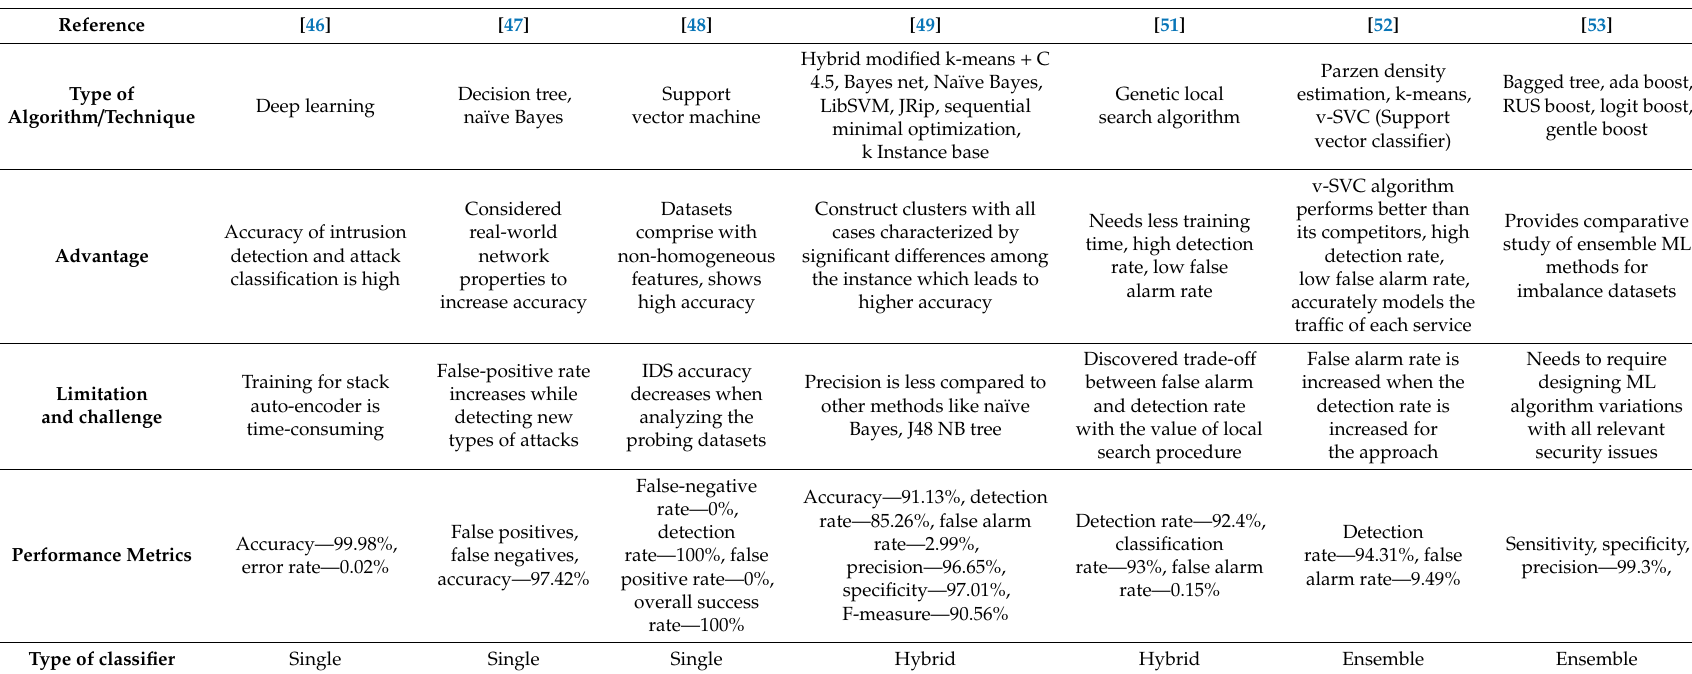
Table 4. Analysis of Anomaly-based Intrusion Detection